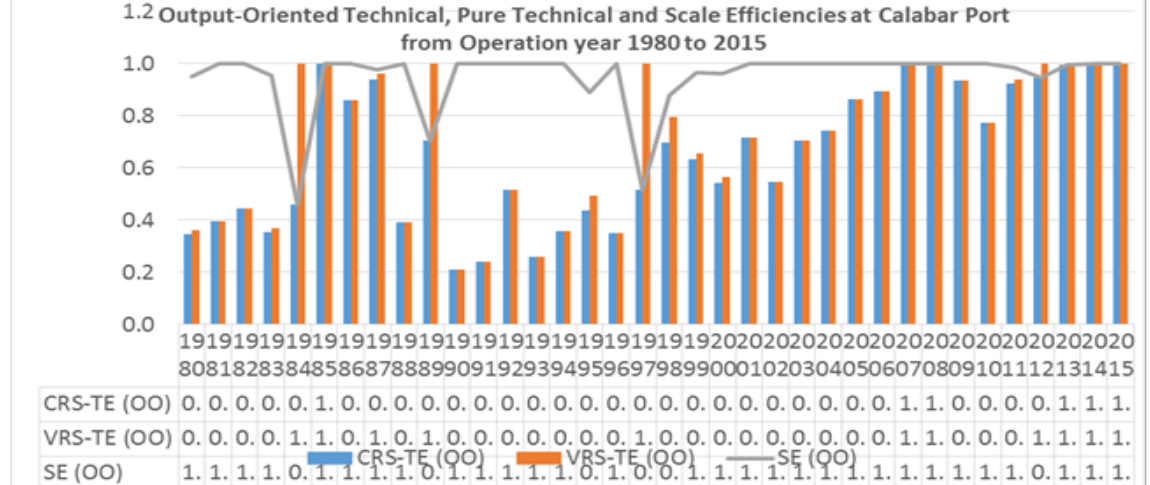
Figure 12: CRS – Technical Efficiency (Output-oriented) and CRS – Scale Efficiency (Output- oriented) at Calabar Port Complex from 1980 –